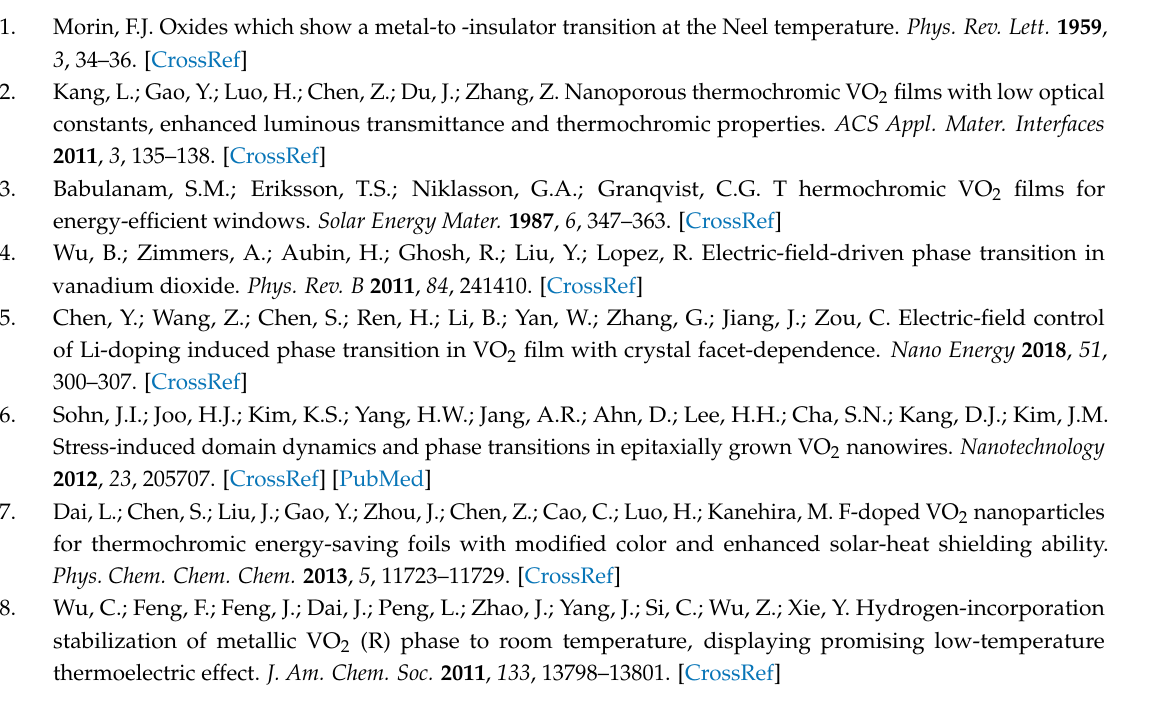
Figure S1: Moment vs applied field curves of un-doped VO 2 powder samples before and after phase transition (300K and 350K), Figure S2: Specific heat capacity vs temperature of un-doped VO 2